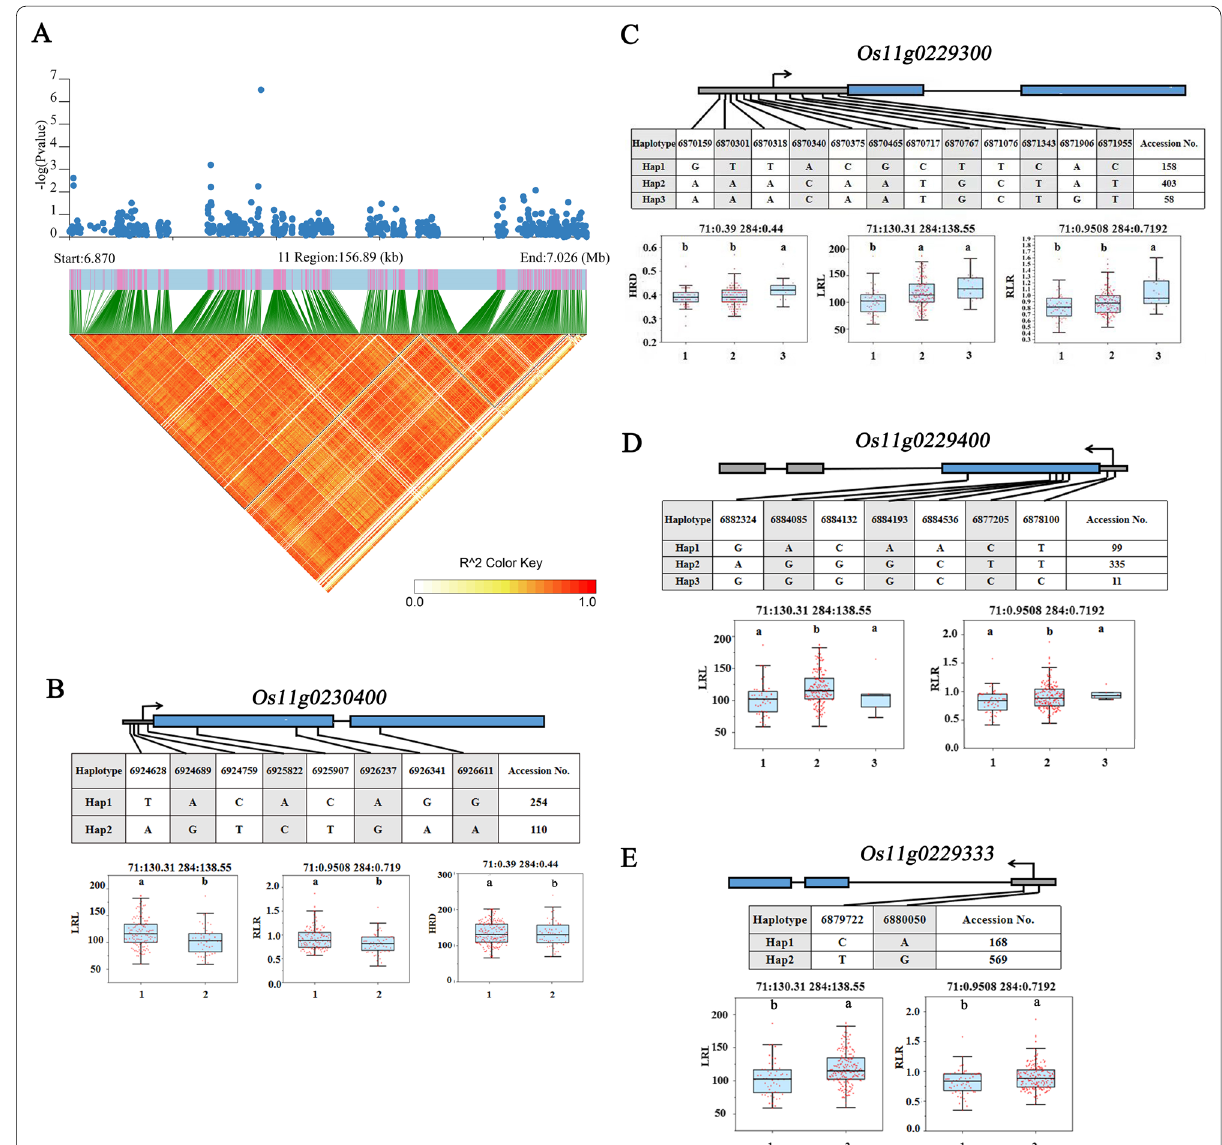
Fig. 8 Associated region and haplotype analysis of Os11g0230400 , Os11g0229300 , Os11g0229400 and Os11g0229333 . A Regional Manhattan plots and LD heatmap of Os11g0230400 , Os11g0229300 , Os11g0229400 and Os11g0229333. B Gene structure and haplotype analysis of Os11g0230400 . C Gene structure and haplotype analysis of Os11g0229300 . D Gene structure and haplotype analysis of Os11g0229400 . E Gene structure and haplotype analysis of Os11g0229333 . LRL: root length under low-nitrogen treatment. RLR: relative value of root length under low and high nitrogen treatments. HRD: root diameter under high-nitrogen